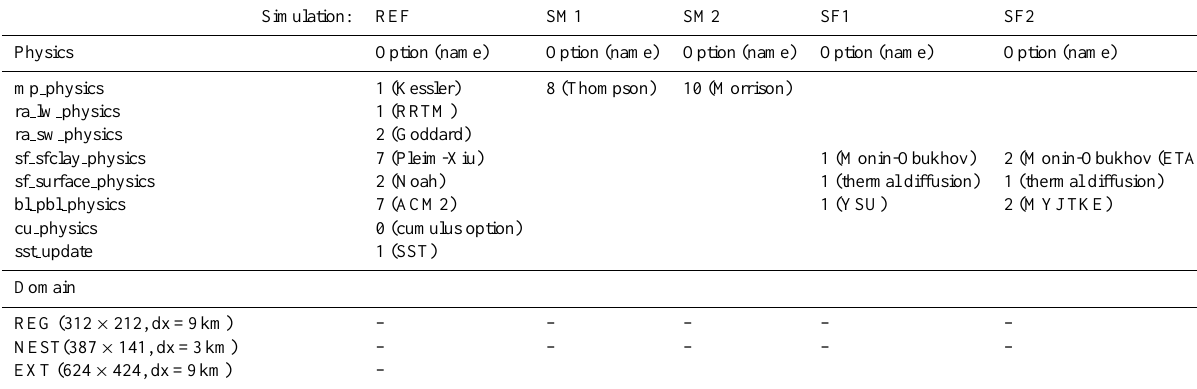
Fig. 6. Model sensitivity to the initialization time for EXT with 81 vertical levels and for profile 5; black line - observations, blue - 00h on 12.11.2008, green - 00h on 10.11.2008, red - 00h on 05.11.2008; gray points - variability of measurements.